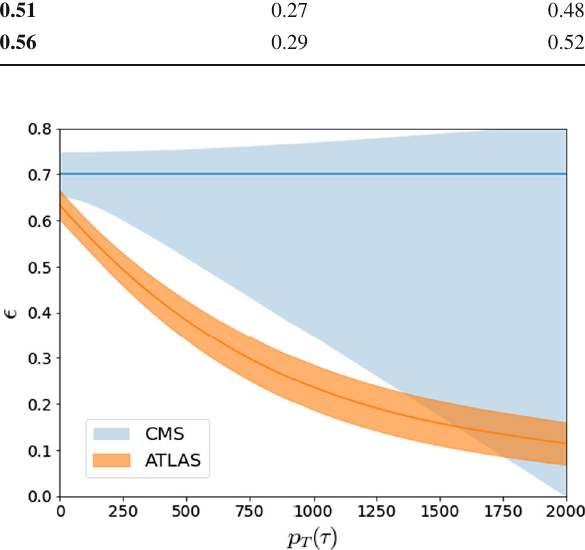
Fig. 1 Comparison between the ATLAS and CMS τ reconstruction efficiency as reported in Refs. [26,27] respectively. In this plot we made the simplified assumption that m T (cid:9) 2 p T , which is true as long as the neutrino is the only missing energy of the event and no other jet is found datasets and obtain the results presented in Table 2. Note also that the same procedure is used with new ATLAS